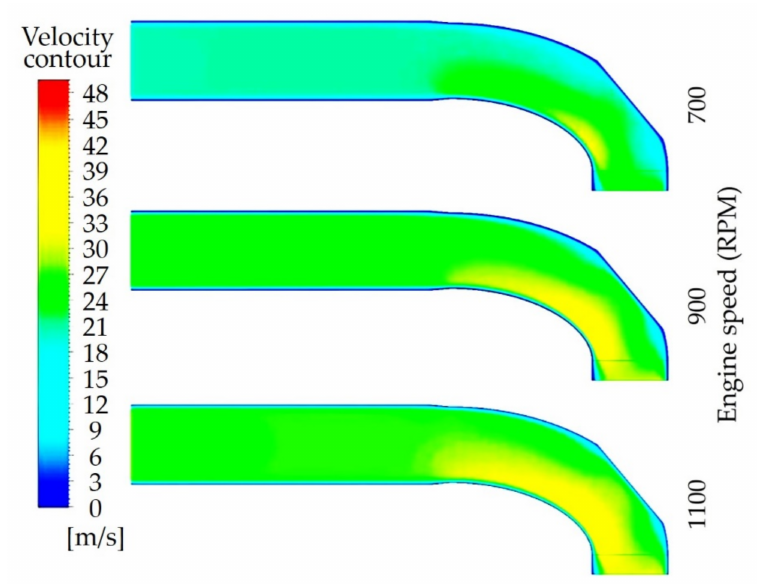
Figure 9. Contours of velocity results of the 3D zone in the intake